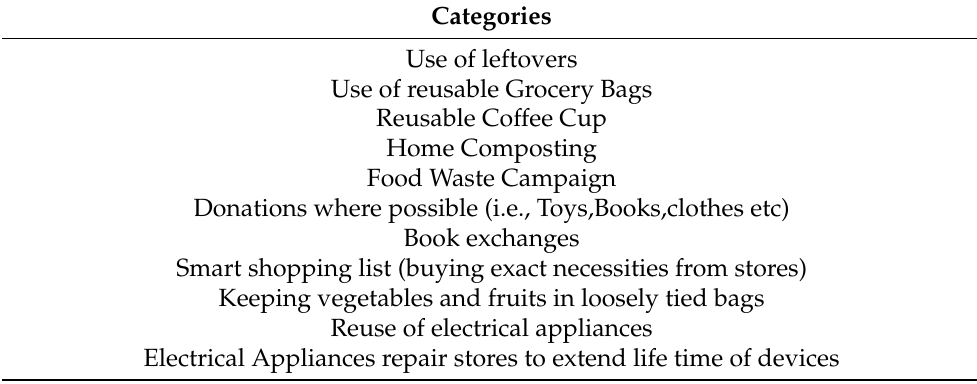
Table 13. Prevention